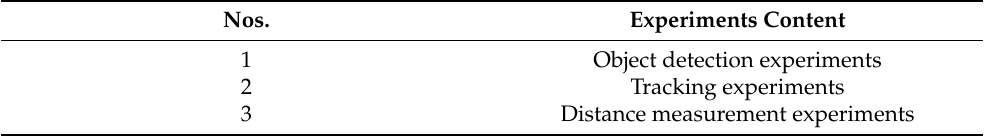
Table 1. Three sets of experiments.